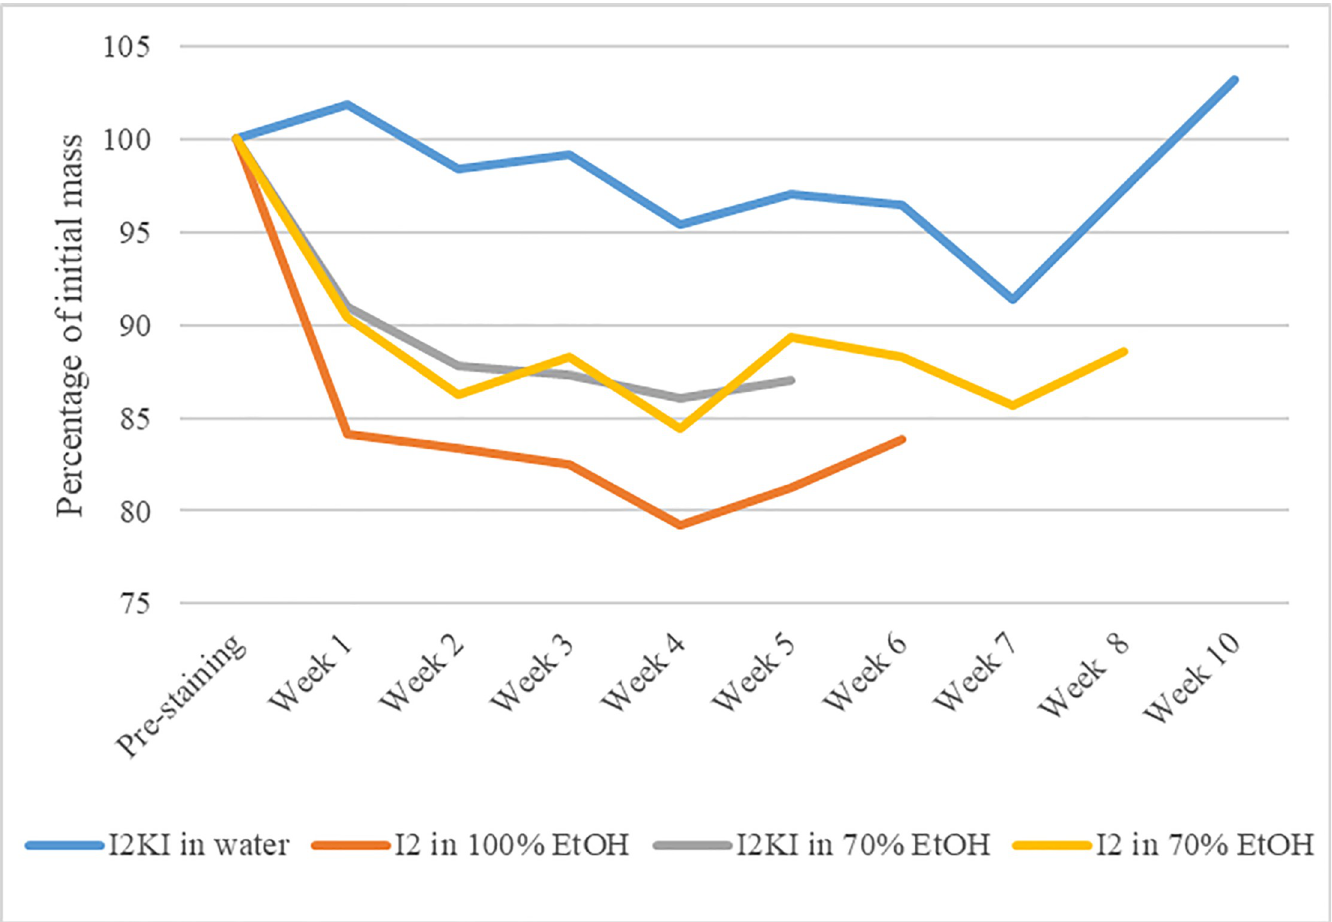
Fig 3. Body mass through time. Body masses of the specimens treated with different iodine stains throughout the staining process.